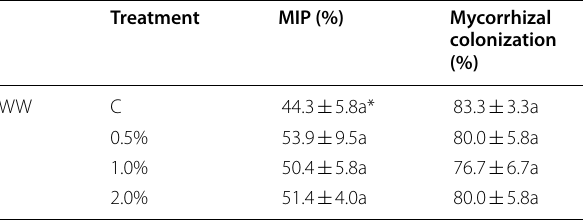
*Values (means standard errors of three replicates per treatment) followed ± by the same letter in a column are not significantly different at P < 0.05 (Tukey’s post hoc test)